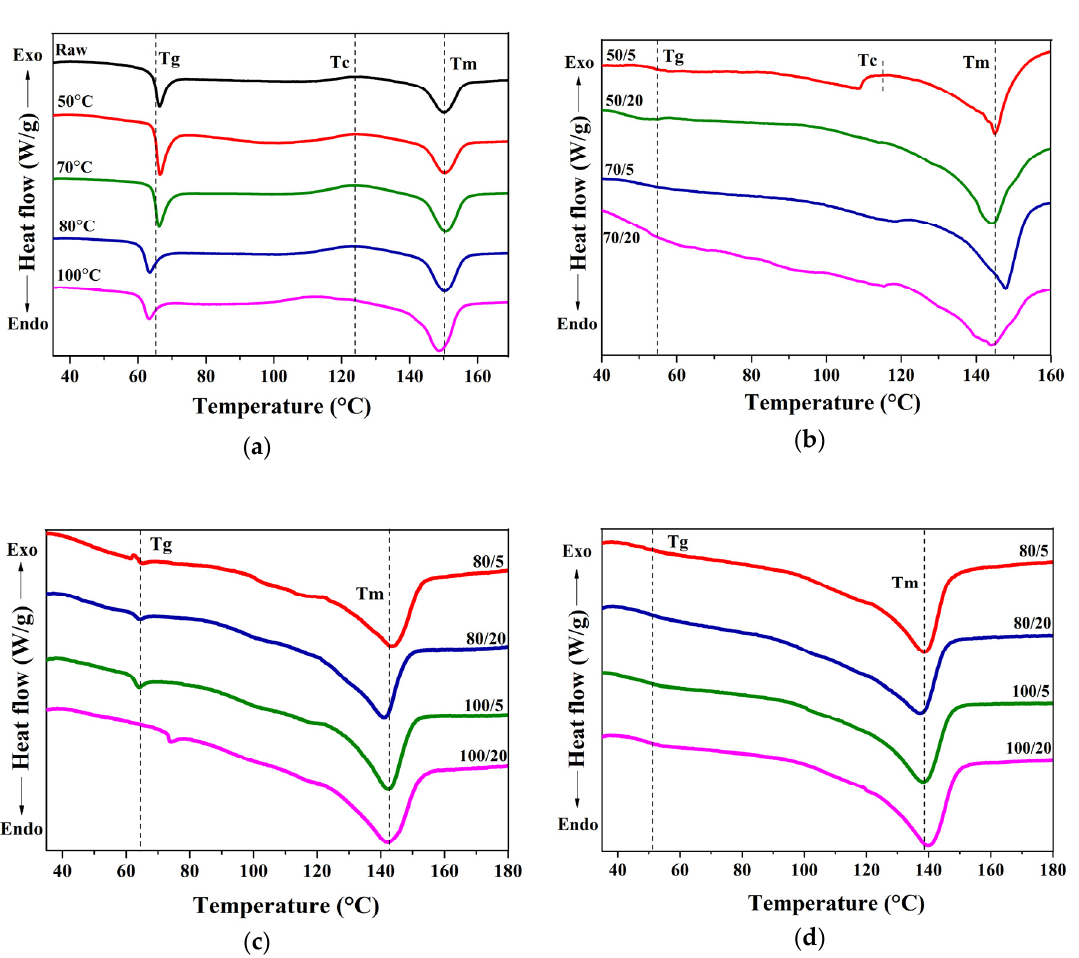
Figure 3. Differential scanning calorimetry (DSC) thermograms of PLLA; raw and thermally-annealed at different temperatures for 20 min ( a ); immersed in ethyl acetate at 50 and 70 °C (5, 20 min) ( b ); immersed in o-dichlorobenzene (ODCB) at 80 and 100 °C (5, 20 min) ( c ); immersed in nitrobenzene at 80 and 100 °C (5, 20 min) ( d ).